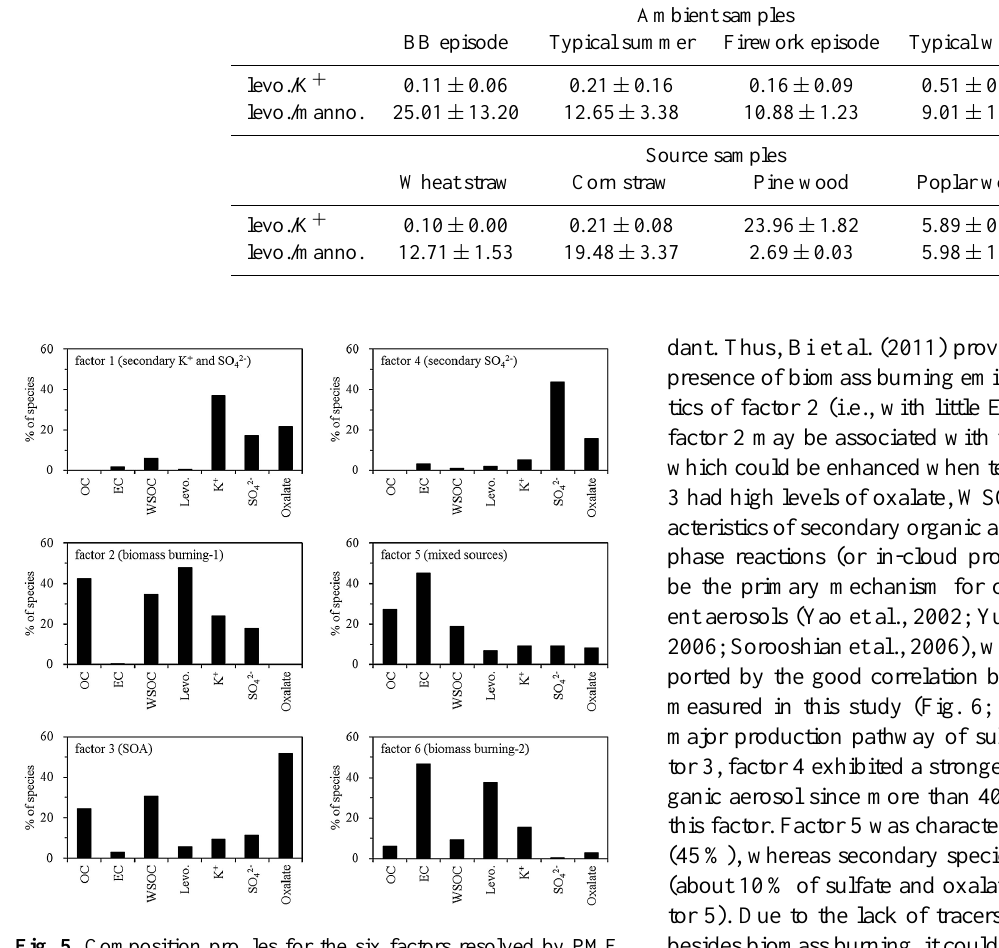
Fig. 5. Composition profiles for the six factors resolved by PMF based on data from the typical summer and winter